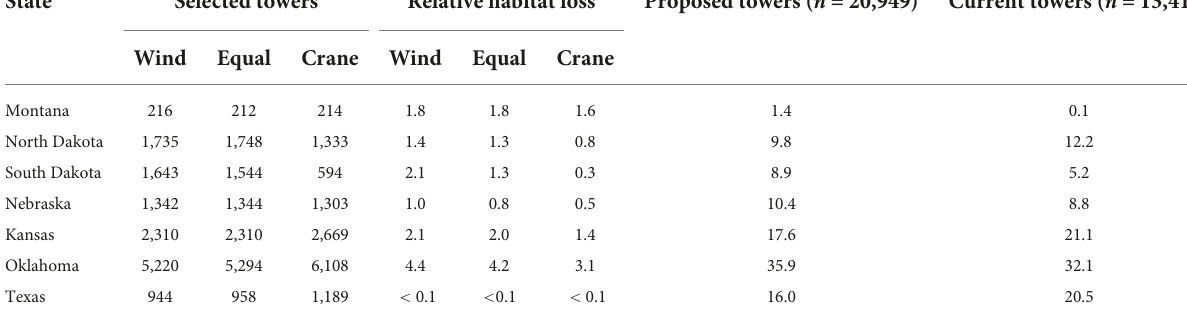
State Selected towers Relative habitat loss Wind Equal Crane Wind Equal